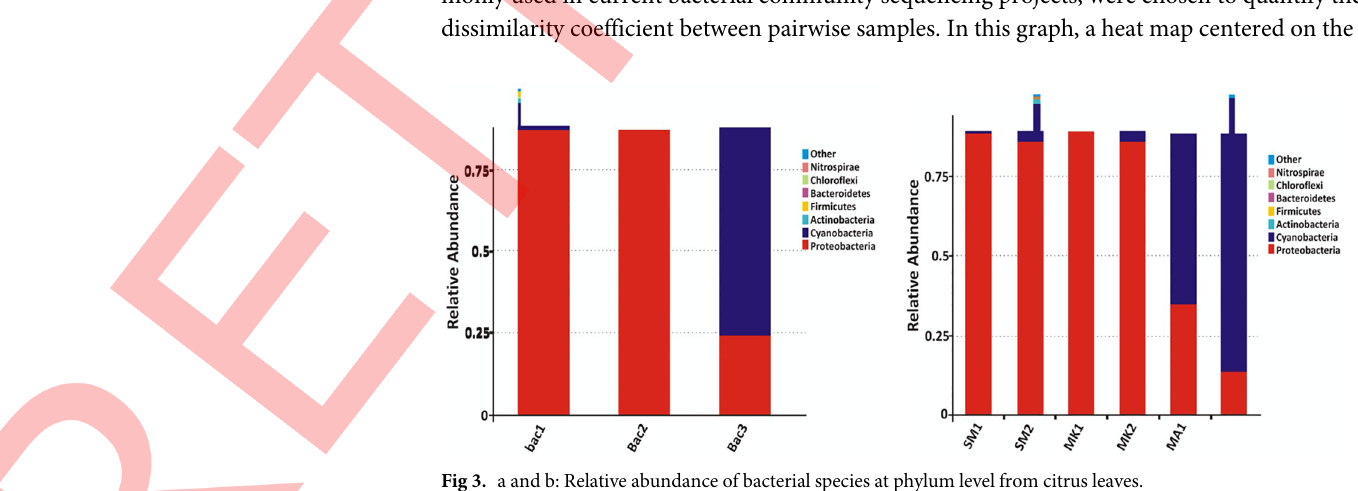
Unweighted vs. weighted unifrac distances, which are phylogenetic indicators that are com- monly used in current bacterial community sequencing projects, were chosen to quantify the dissimilarity coefficient between pairwise samples. In this graph, a heat map centered on the